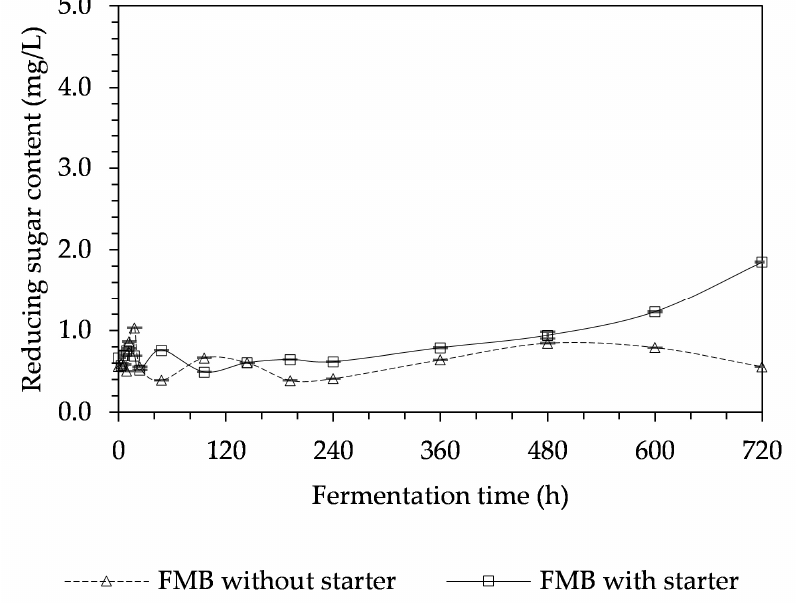
Figure 5. The change of reducing sugar content in a fermented mushroom beverage (FMB) with and without starter culture L. plantarum SK15 during fermentation time.